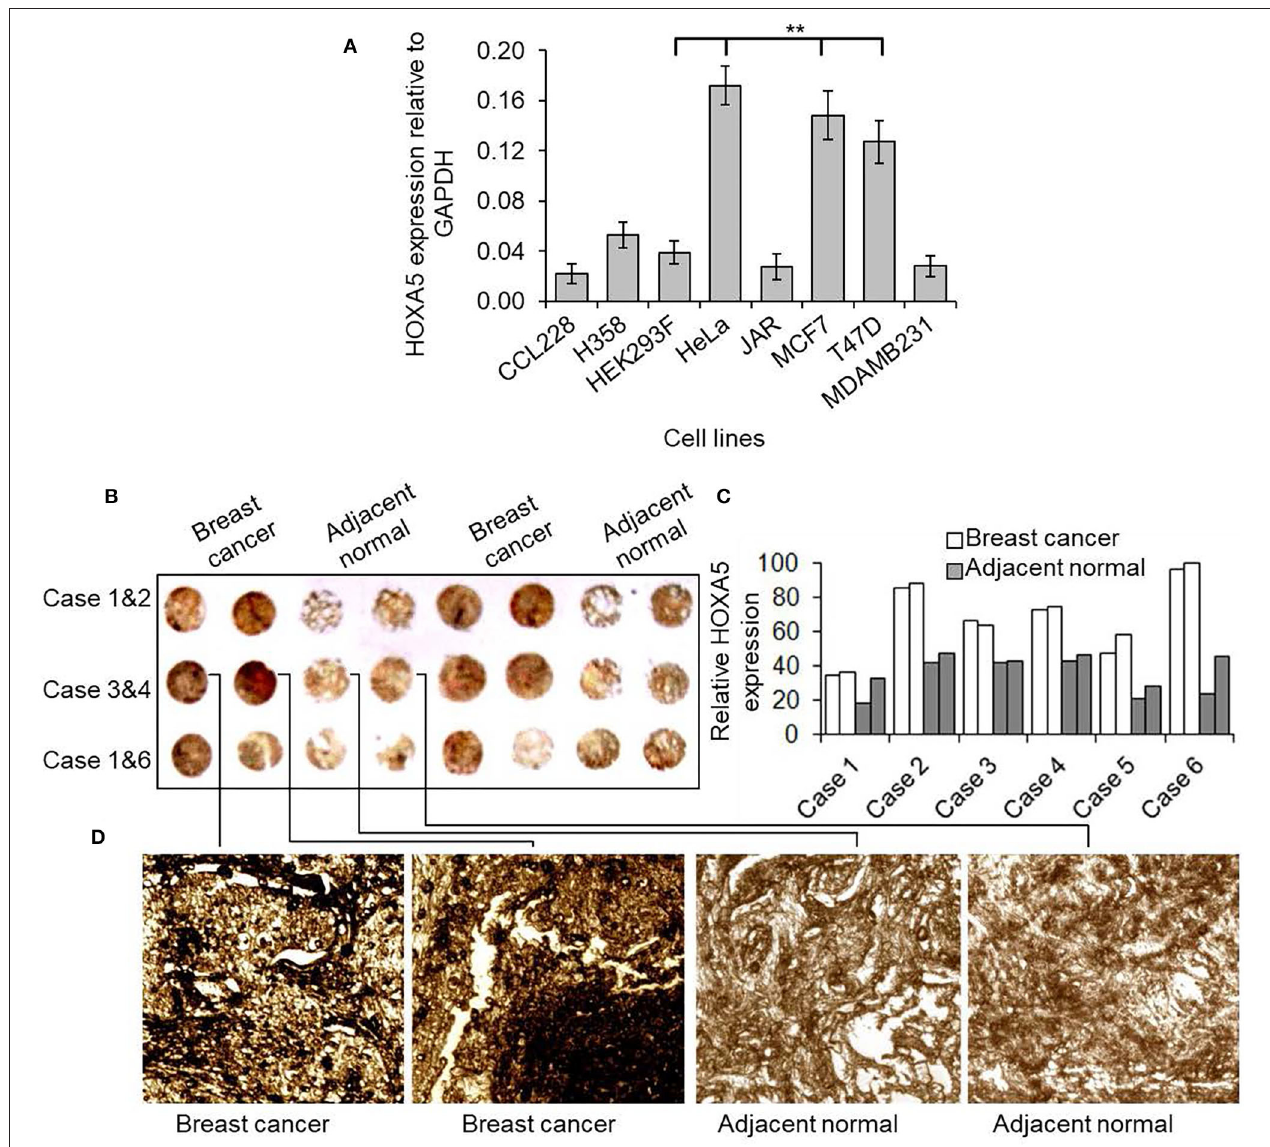
FIGURE 1 | HOXA5 expression in breast cancer cells and tissues. (A) Comparison of HOXA5 expression in different cell lines. The total RNA was isolated from CCL228 (colon cancer), H358 (lung cancer) HeLa (cervical cancer), JAR (placental cancer), MDAMB231 (ER-negative breast cancer), T47D (ER-positive breast cancer), MCF7 (ER-positive breast cancer) cell lines and analyzed by RT-qPCR using primers specific to HOXA5 and GAPDH (loading control). HOXA5 expression relative to GAPDH is plotted. Bars indicate averages ± standard errors ( n = 3). **denotes p < 0.0001 compared to HEK293F control cells (B–D) HOXA5 expression in breast cancer tissue. Tissue microarray slide (containing six cases of human breast cancer cases and respective adjacent normal breast tissue) was subjected to DAB staining with HOXA5 antibody. The HOXA5 expression level was quantified (C) . A magnified view of case 3 is in (D)